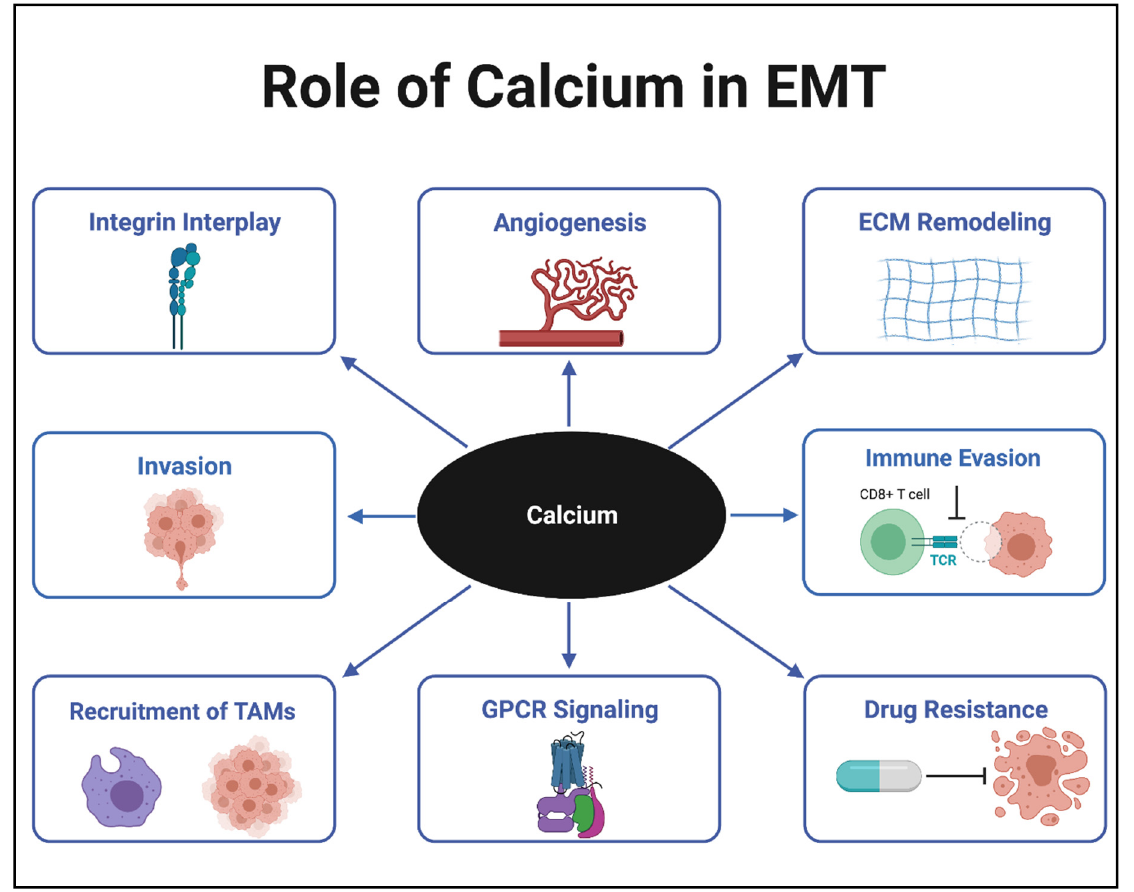
Figure 1. Role of calcium in epithelial-to-mesenchymal transition (EMT). Tumor associated macrophages (TAMs); Extracellular matrix (ECM); G-protein coupled receptor (GPCR); T-cell receptor (TCR).